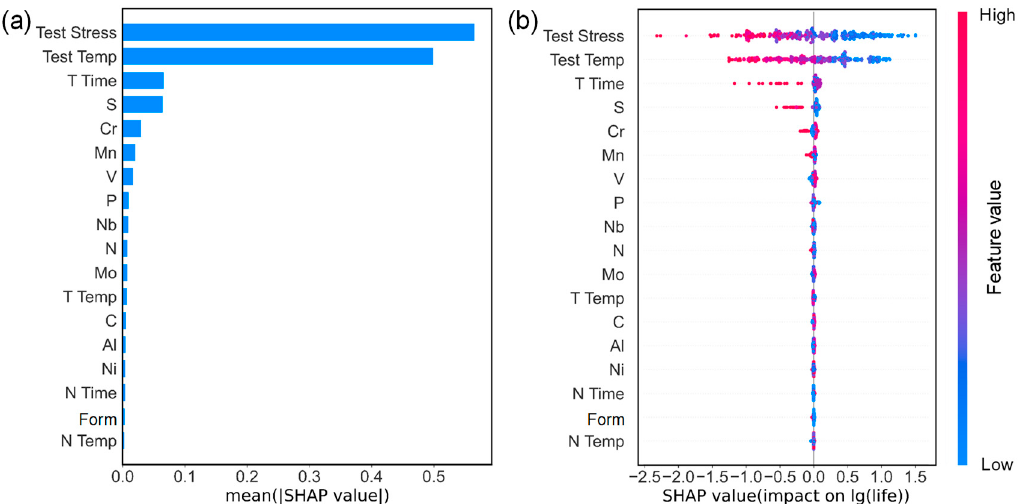
Figure 4. Results of SHAP value: ( a ) Importance of input features, and ( b ) summary plot of SHAP value.